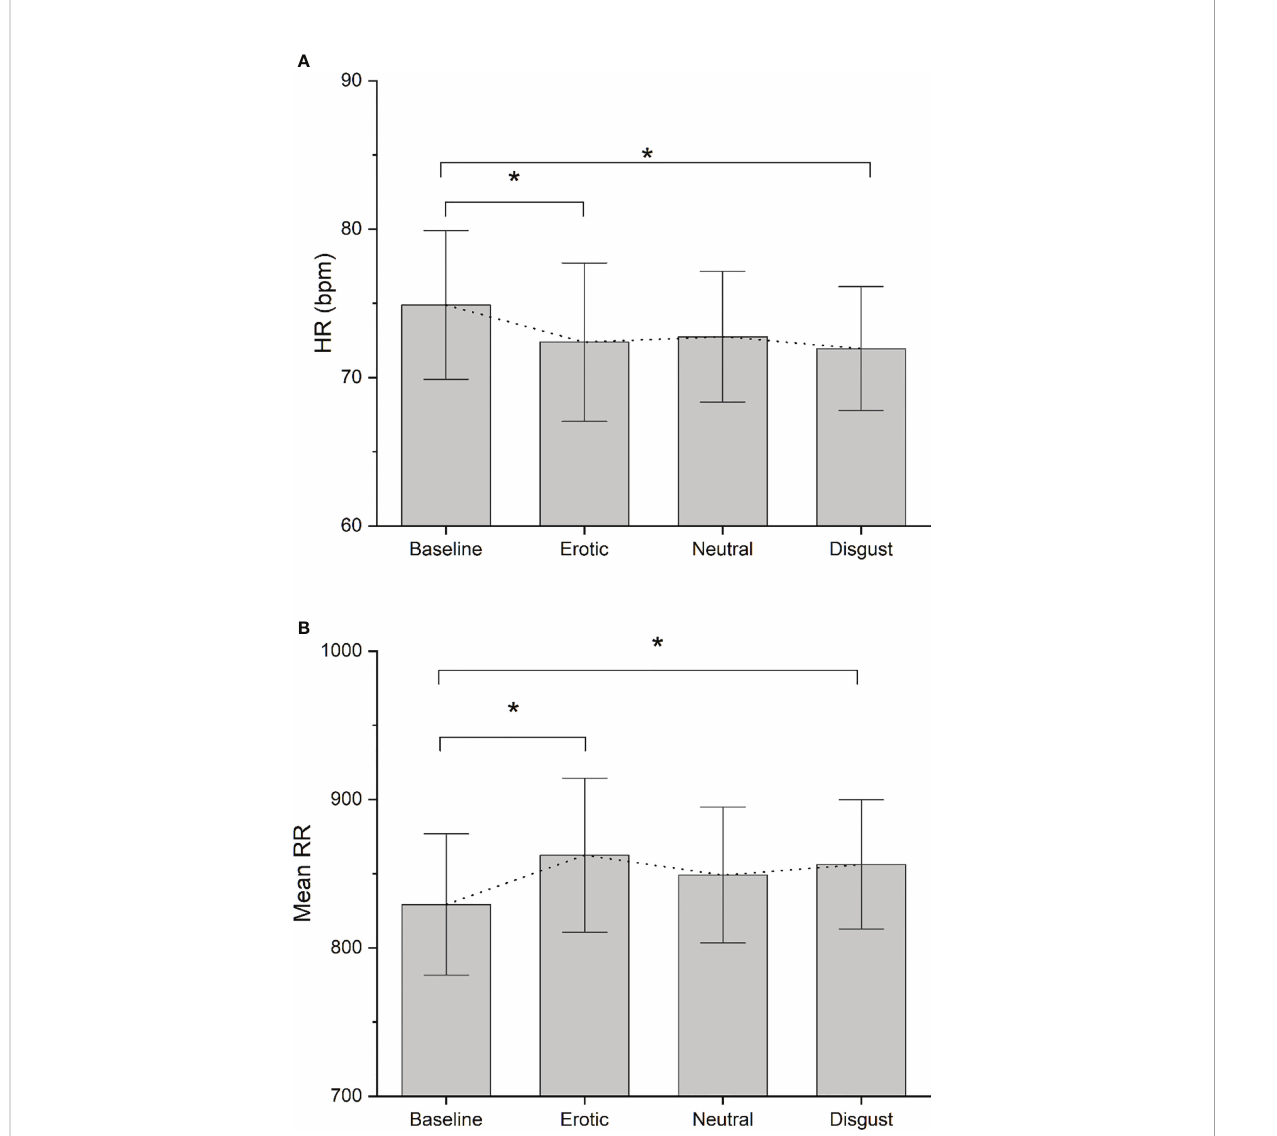
FIGURE 4 (A) Bar-chart representing Mean HR recorded in each experimental block in FHA group. Error bars represent standard errors. Dot-line connects the mean value recorded in each block. *p value < 0.05; (B) Bar-chart representing Mean RR recorded in each experimental block in FHA group. Error bars represent standard errors. Dot-line connects the mean value recorded in each block. *p value <